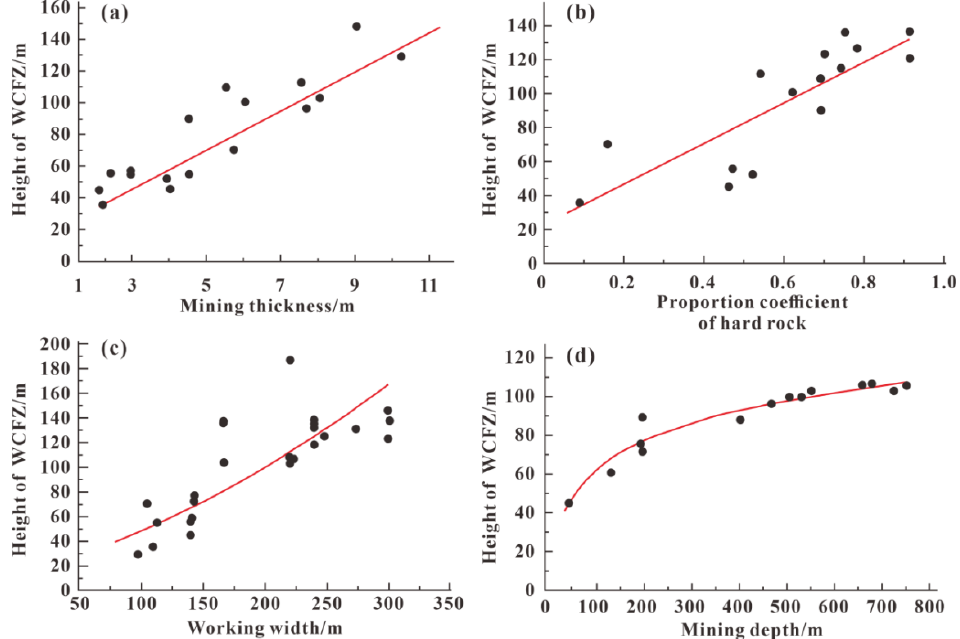
Figure 2. The relationship between the height of WCFZ and main controlling factors: ( a ) Mining thickness, ( b ) proportion coefficient of hard rock, ( c ) working width, ( d ) mining